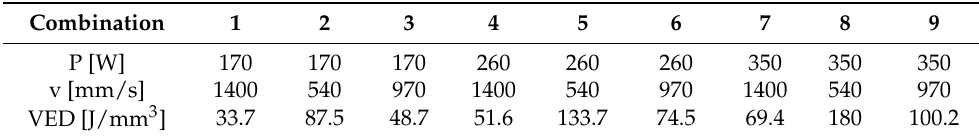
Table 5. Input parameter